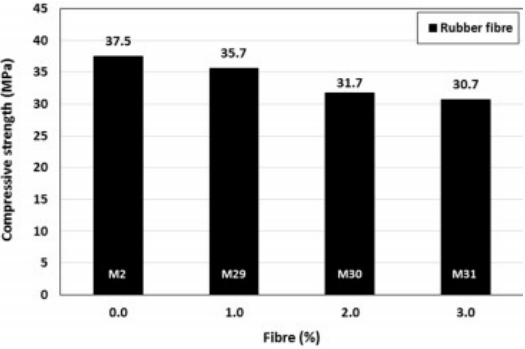
Figure 21. Effects of rubber fiber additives on rubberized concrete [6].